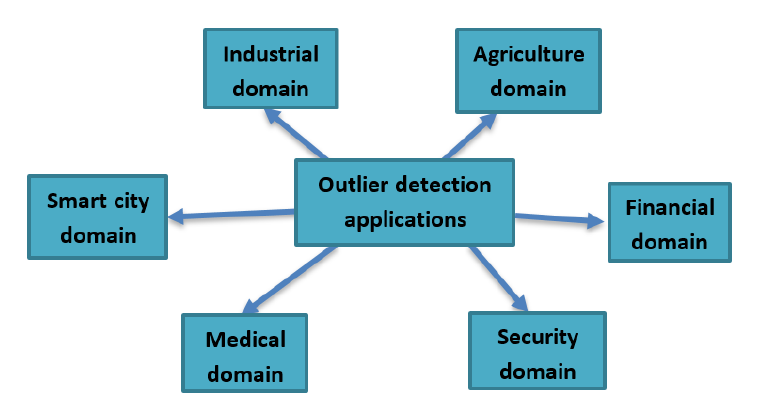
Figure 1. Applications area of outlier detection in